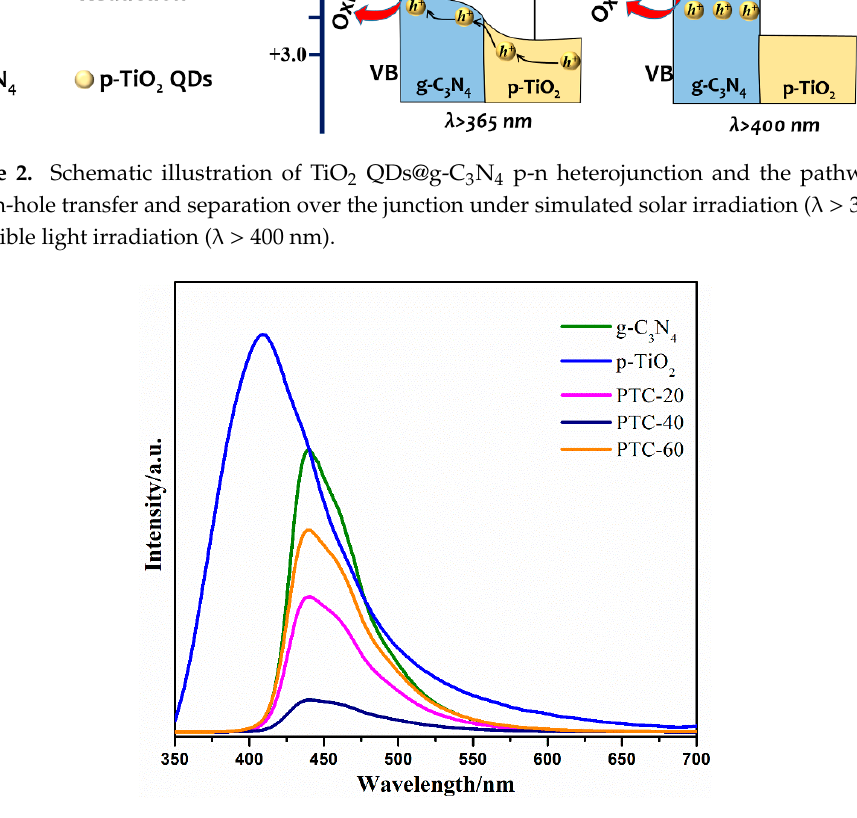
Figure 9. Pseudo-first-order reaction rate in degradation of methyl orange (MO) and phenol under: ( a ) full solar spectrum and ( b ) visible light ( λ > 400 nm). The photocatalytic H 2 evolution reaction rate is shown in Figure 10a, the H 2 release rate for g- C 3 N 4 , PTC-20, PTC-40 and PTC-60 is 186 μ mol·g − 1 ·h − 1 , 712 μ mol·g − 1 ·h − 1 , 1072 μ mol·g − 1 ·h − 1 and 838 μ mol·g − 1 ·h − 1 , respectively. It is clearly that the H 2 evolution rate of PTC-40 is the fastest, which is 5.8-